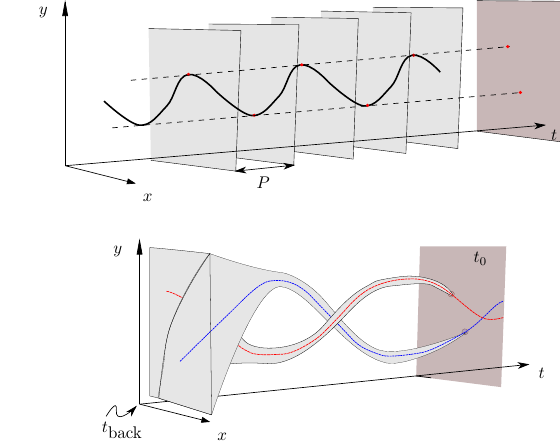
Fig. 4. (a) The stroboscopic section is obtained by superimposing the system state every forcing period ( P ), here illustrated for a 2 : 1 synchronisation. (b) The pullback section at time t 0 is obtained by superimposing the system states obtained by initialising the system with the ensemble of all possible initial conditions far back in time, here at t back . The particular example shows a global pullback attrac- tor made of two local pullback attractors (in dashed red and blue), the sections of which are seen at t . Also shown is the convergence of initial conditions towards the pullback attractors, in